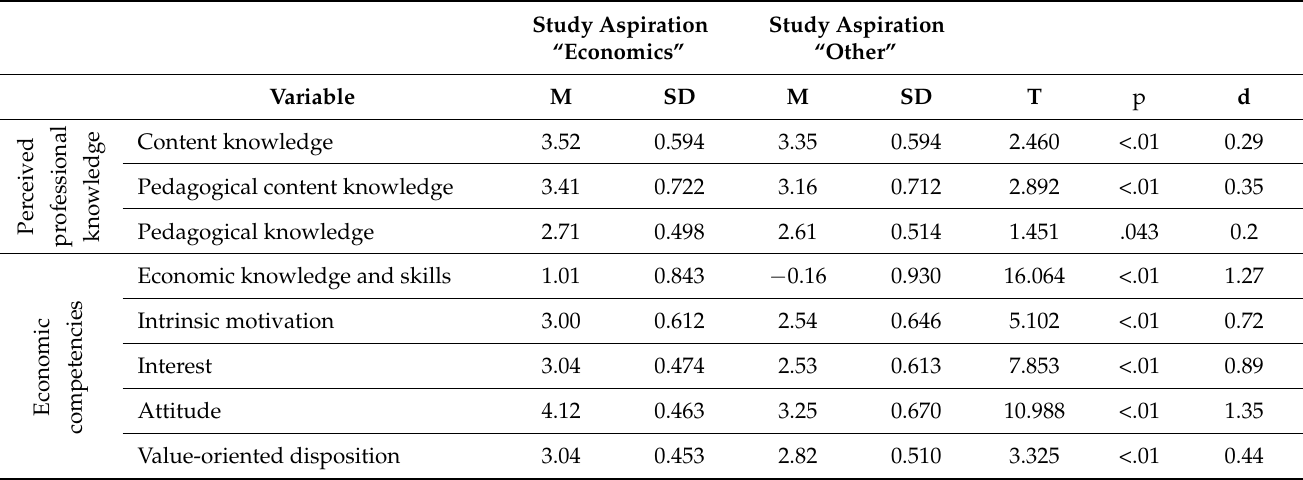
Table 12. Group differences of students who chose economics or another field of study. Study Aspiration Study Aspiration “Economics”